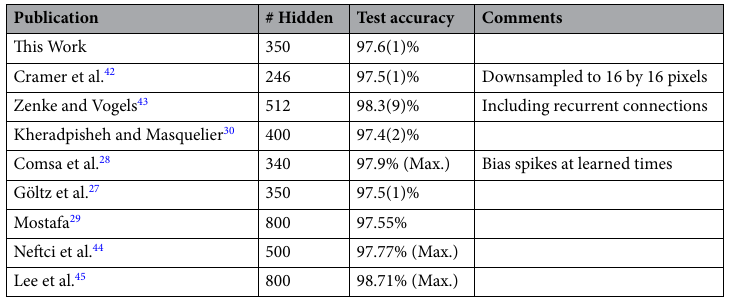
Table 4. Comparison of previously published classification results on the MNIST dataset for spiking neural networks that are trained using supervised learning with a single, fully connected (non-convolutional) hidden layer and temporal encoding of input data. The second column provides the number of hidden